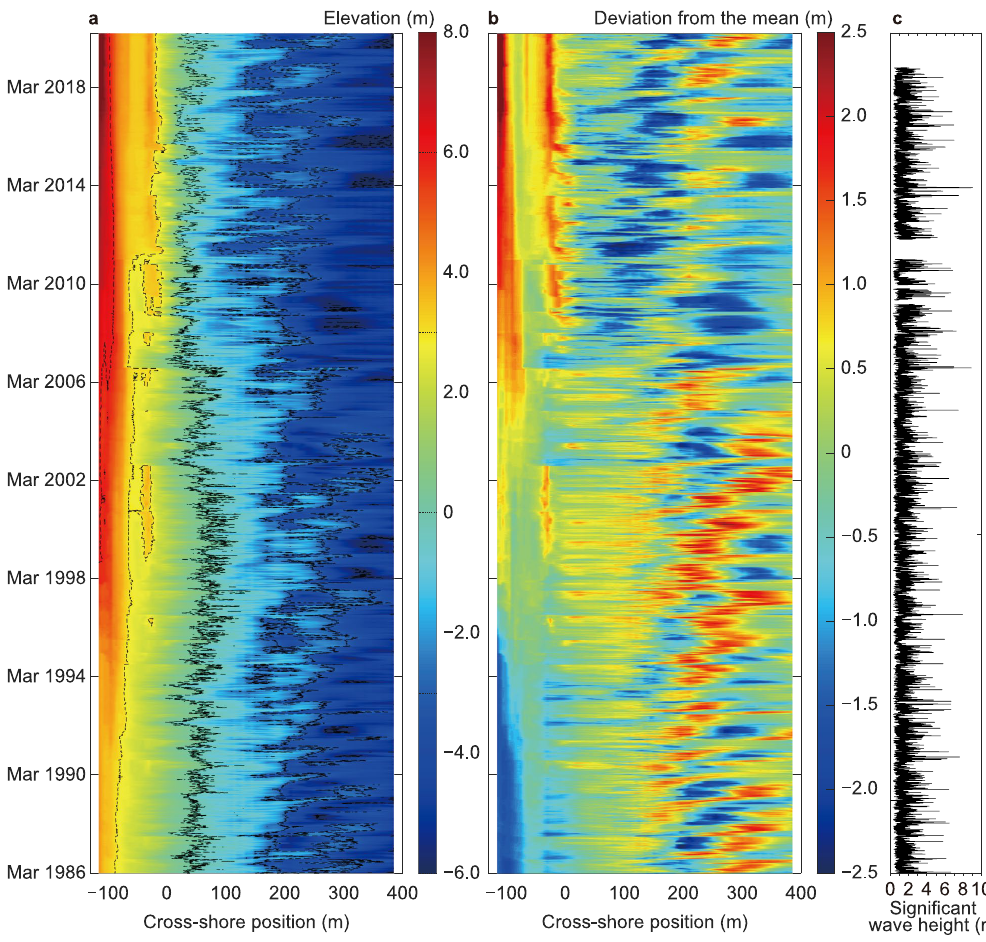
Figure 4. Time-series beach profile. ( a ) Time-series contour of observed beach profile; ( b ) time-series of deviation from the mean profile; ( c ) time series of significant wave